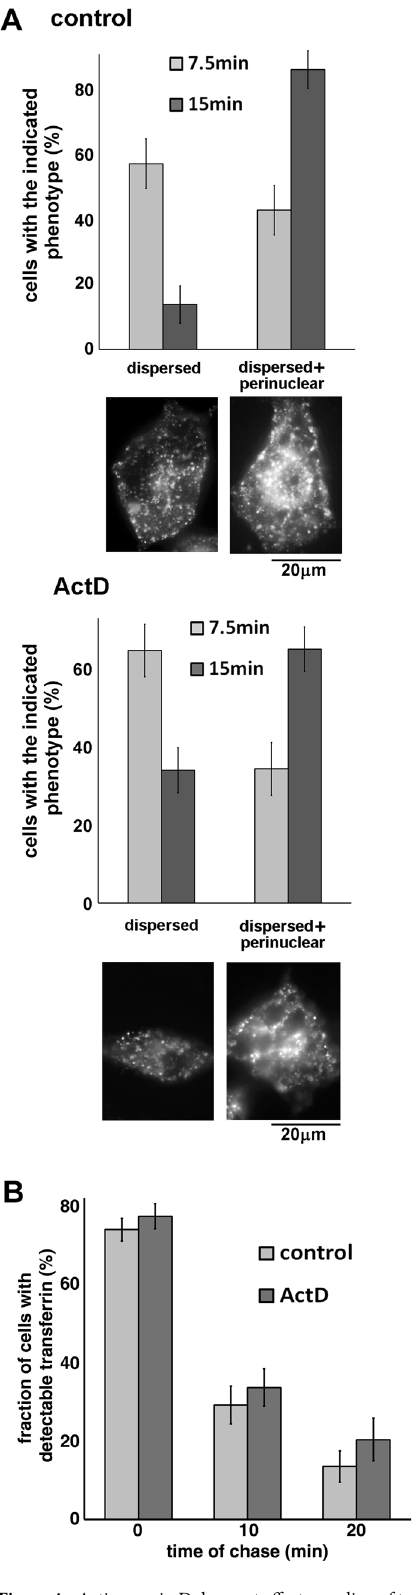
Figure 4. Actinomycin D does not affect recycling of transferrin in 3T3-L1 adipocytes. Panel ( A ): 3T3-L1 adipocytes were pre-treated or not with ActD (5 µM) for 18 h, and endocytosis of transferrin was measured for 7.5 and 15 min at 37 °C as described in Materials and Methods . Dispersed—no preferential localization of puncta in the perinuclear area; dispersed + perinuclear − significant fraction of puncta is localized in the perinuclear area. The error bars represent standard deviations. Representative images of cells with attributed phenotypes are shown at the bottom. Panel ( B ): Exocytosis of transferrin was measured in 3T3-L1 adipocytes treated or not treated with ActD (5 µM) for 18 h as described in “Materials and methods” section. The error bars represent standard